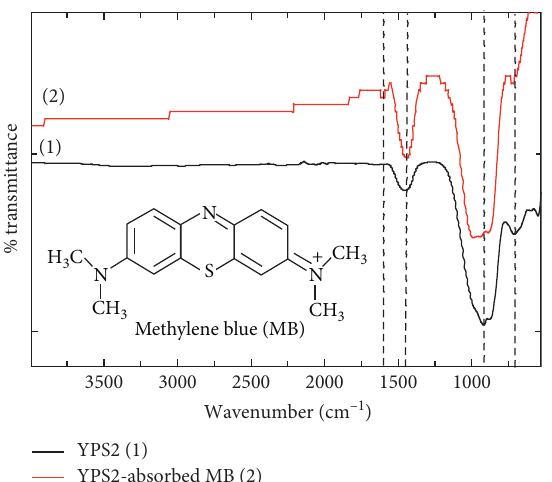
Figure 8: IR spectra of the YPS2 sample and YPS2-absorbed methylene blue at initial MB concentration of